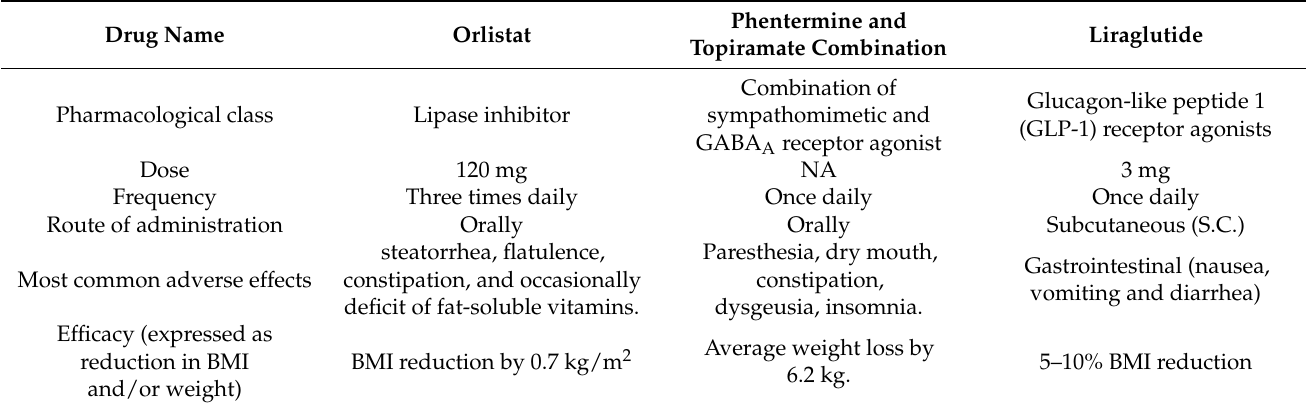
Table 1. FDA-approved medications for pediatric